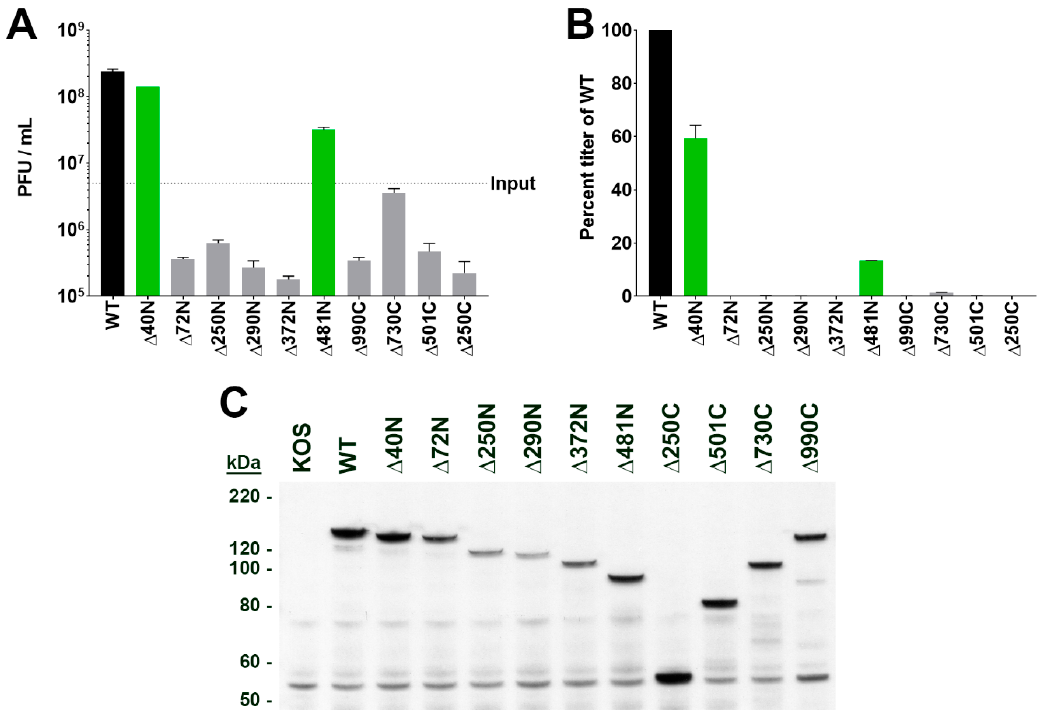
Figure 2. The carboxyl half of pUL37 is sufficient for replication of virus in tissue culture. Mutant viruses were analyzed by single-step growth curves. Vero cells (5 × 10 5 ) were infected at MOI of 10 PFU/cell. The infected cells were harvested at 24 h post-infection. The lysates were sonicated and serial dilutions plated on BD45 cell monolayers to enumerate virus titer. Data are plotted as PFU/mL from the infected cell lysate with input virus inoculum indicated ( A ) and percent titer relative to the wild-type (WT) UL37–EGFP virus ( B ). Each value is an average of two biological replicates. ( C ) Accumulation of the pUL37 mutant polypeptides was examined by immunoblot methods. Vero cells were infected as above and total cell lysates were analyzed by SDS-PAGE (4–12% NuPAGE gradient gel), followed by transfer to nitrocellulose membranes. The blot was probed with rabbit anti-GFP antibodies to confirm stable expression of all truncated pUL37–EGFP fusion proteins. Protein standards are shown on the left of the blot.